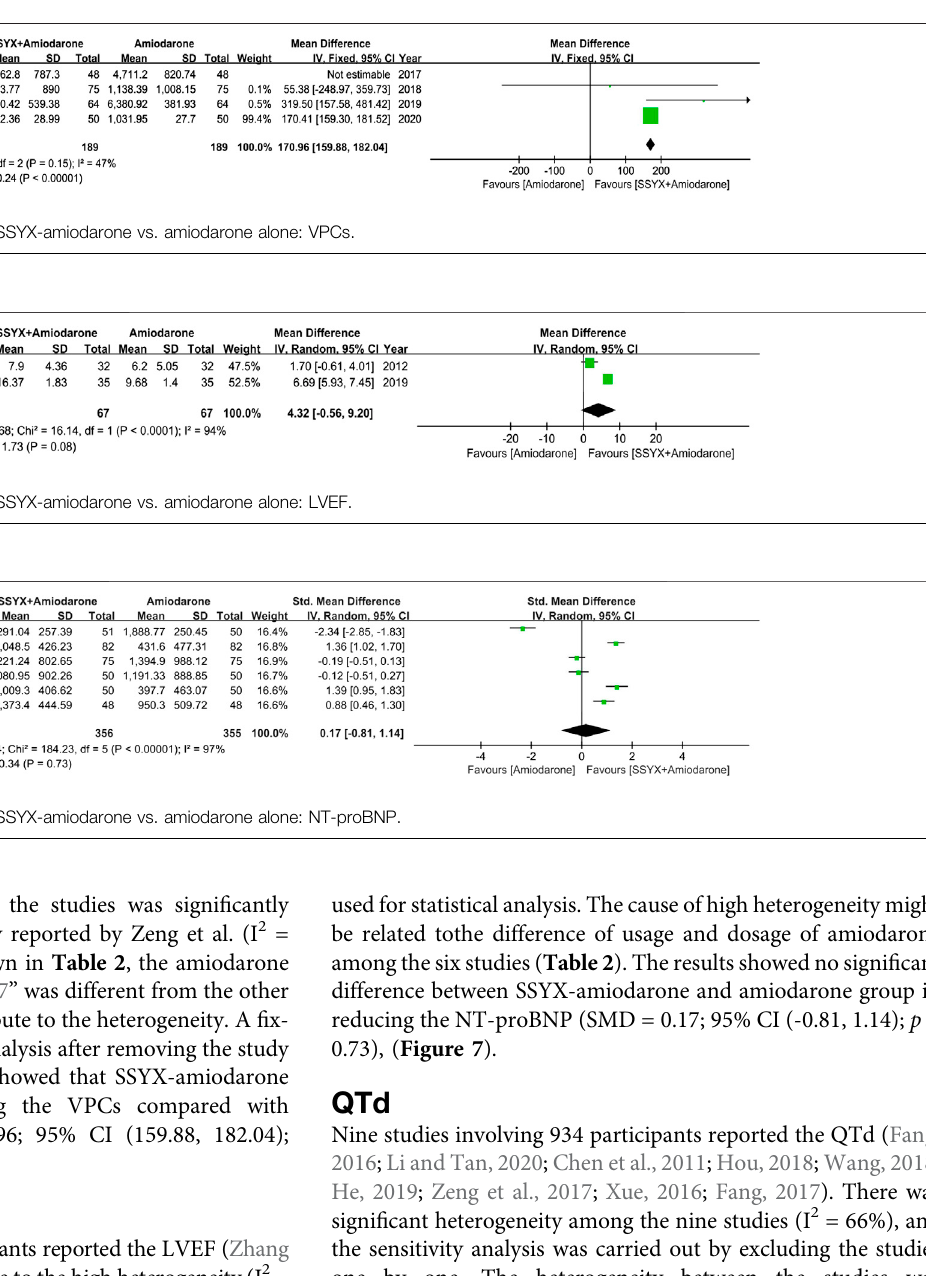
Frontiers in Pharmacology |